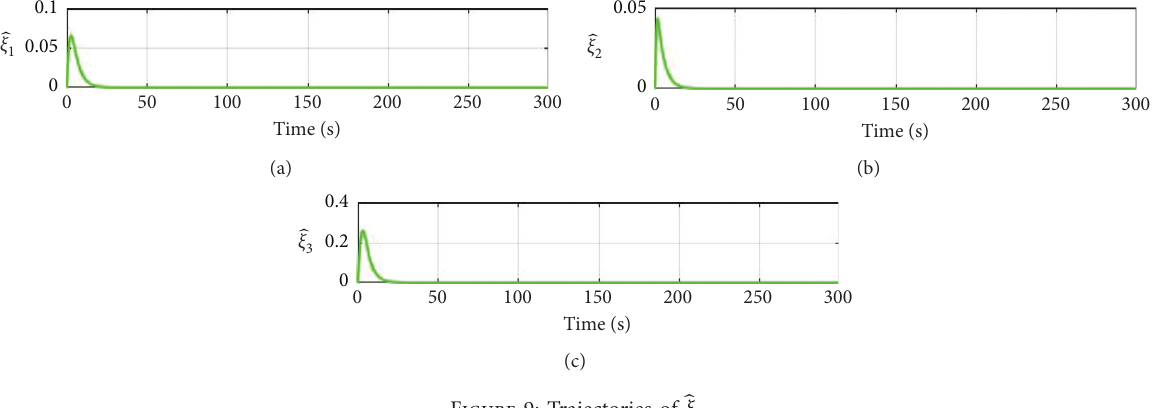
Figure 9: Trajectories of 􏽢 ξ .